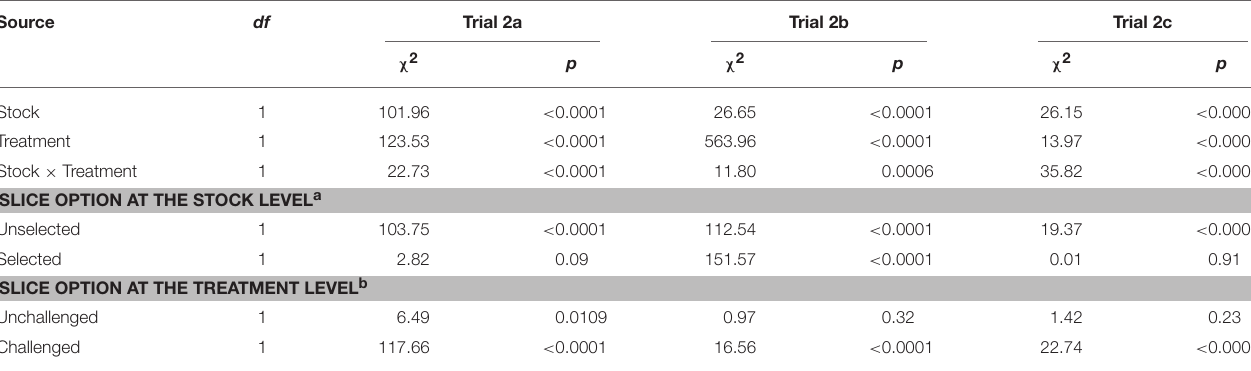
TABLE 2 | Logit analysis of the mortality at the end of the trial on day 7 for unchallenged and challenged larvae when using selected OsHV-1-resistant or unselected broodstocks for 4, 10, and 16 day-old larvae in trials 2a, 2b, and 2c, respectively. Source